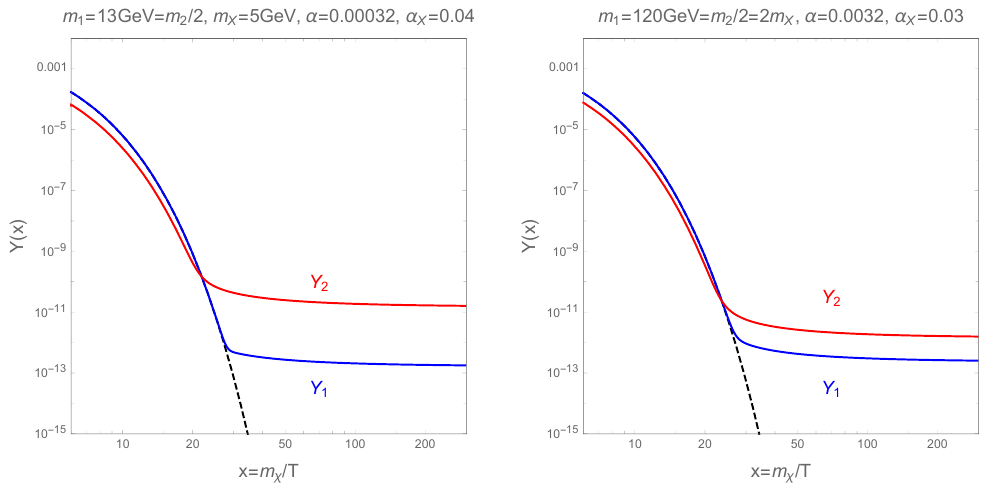
Figure 7 . The same as in figure 6. We took m 1 = m 2 / 2 = 13 GeV , m X = 5 GeV and α = 0 . 00032 , α X = 0 . 04 , on left (B3), and m 1 = m 2 / 2 = 120 GeV = 2 m X and α = 0 . 0032 , α X = 0 . 03 , on right